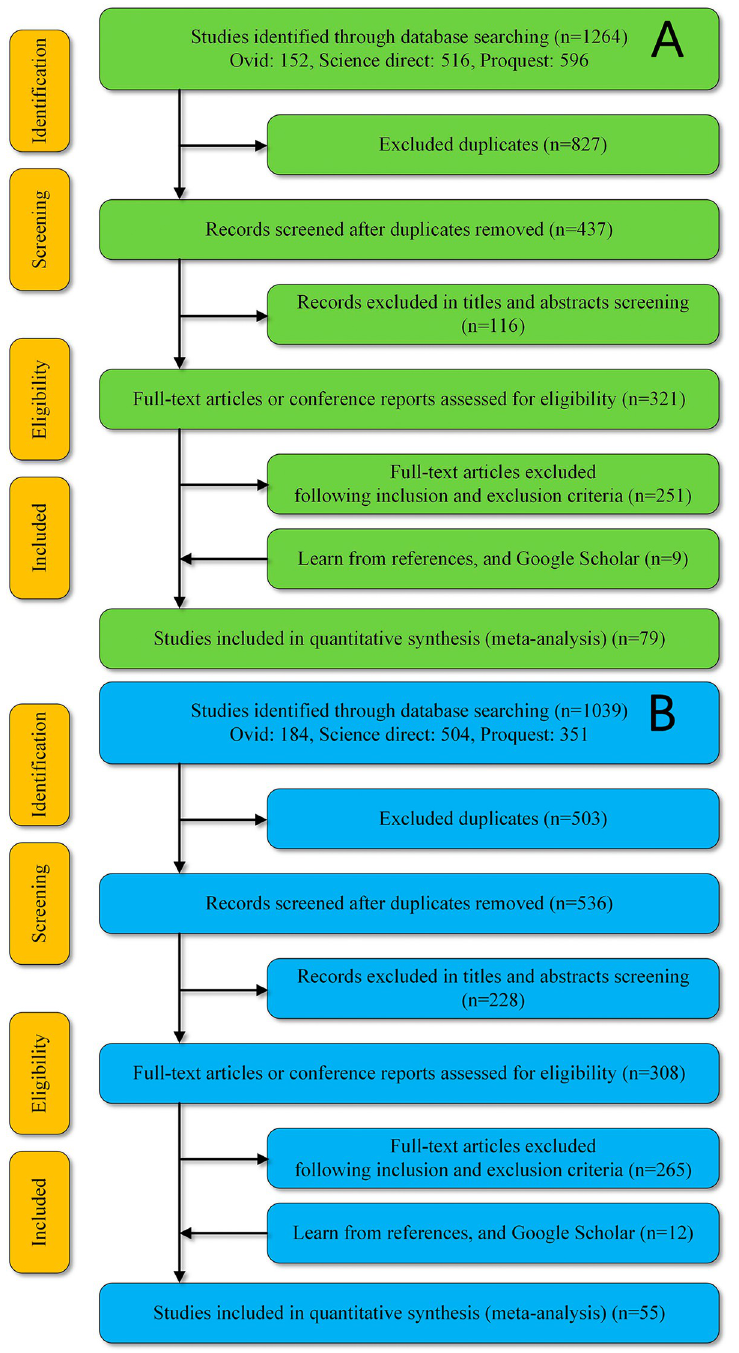
Fig 1. Summary of the study selection processes for MBC (A) and Shannon index (B) meta-analyses. M-I: 8.68) as well as inhibited and reduced fungal diversity (M-Z: − 1.15 and M-I: − 1.03) (Fig 2C). The TSA indicated that the analysis results were reliable (Fig 2D–2F). The TSA also showed that the results of the manual effect MBC test exceeded the threshold value, and there